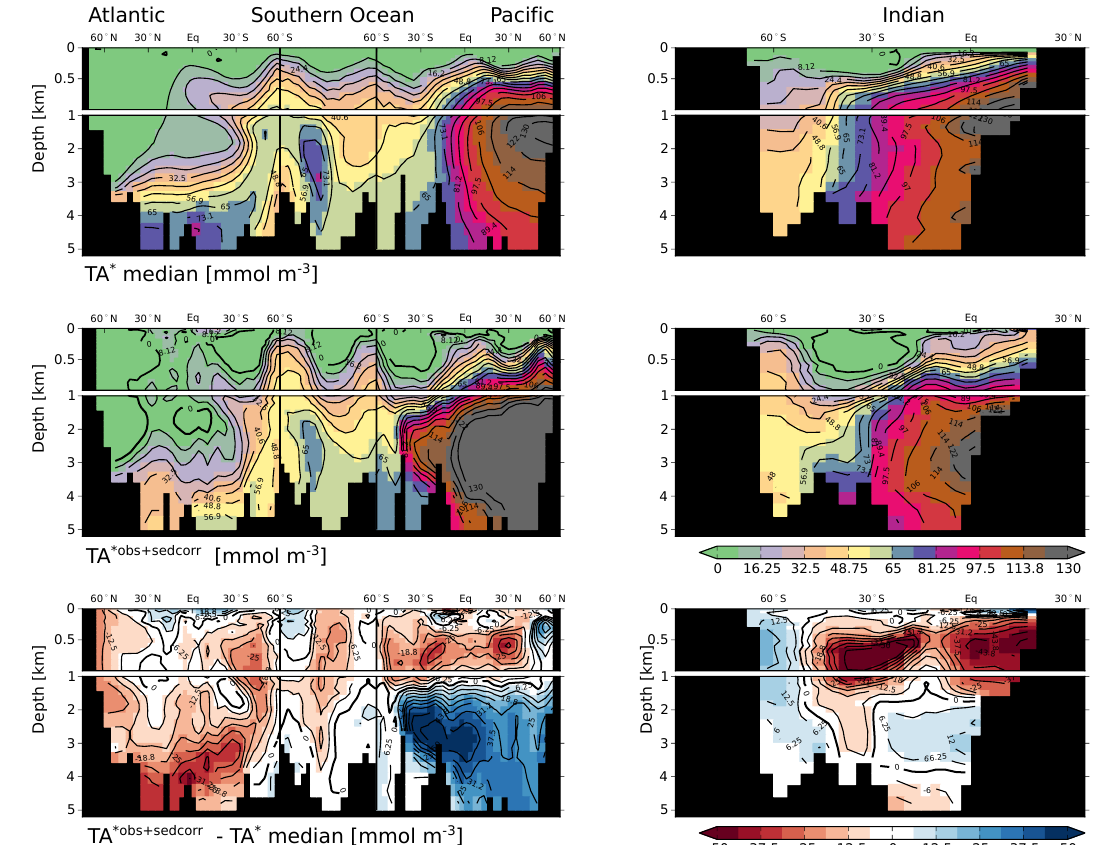
Figure 5. Observation-based vs. simulated TA ∗ . Left column: modelled (median) TA ∗ , observed TA ∗ , and their difference in a cross section through the Atlantic (25 ◦ W), Southern Ocean (58 ◦ S), and Pacific (175 ◦ W). Right column: the same for a cross section along 95 ◦ E in the Indian Ocean. The correlation coefficient, relative standard deviation ( σ obs. ), and root mean square error (RMSE) between the simulated rel. and observation-based fields are 0.83, 1.09, and 17.7mmolm − 3 in the Atlantic; 0.88, 0.8, and 23.8mmolm − 3 in the Pacific; 0.87, 0.86, and 19.8mmolm − 3 in the Indian